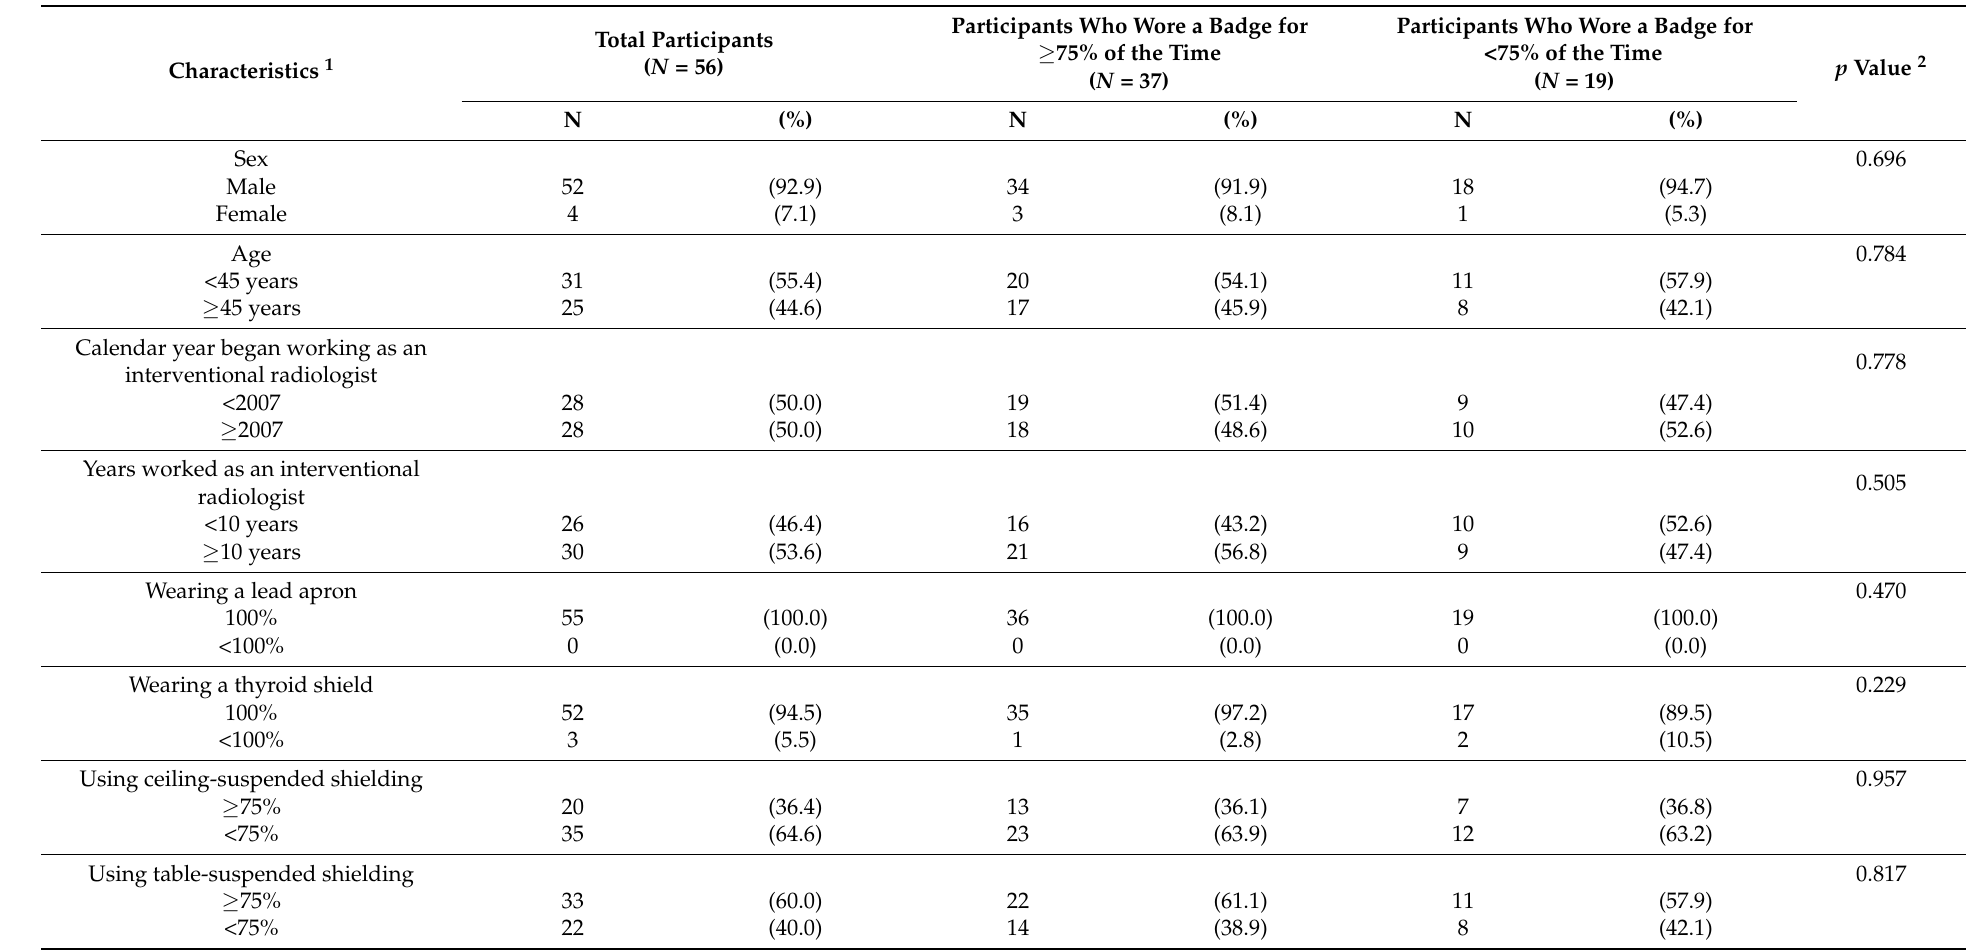
Table 1. Characteristics of the study participants by wearing the KCDC (Korea Centers for Disease Control and Prevention)